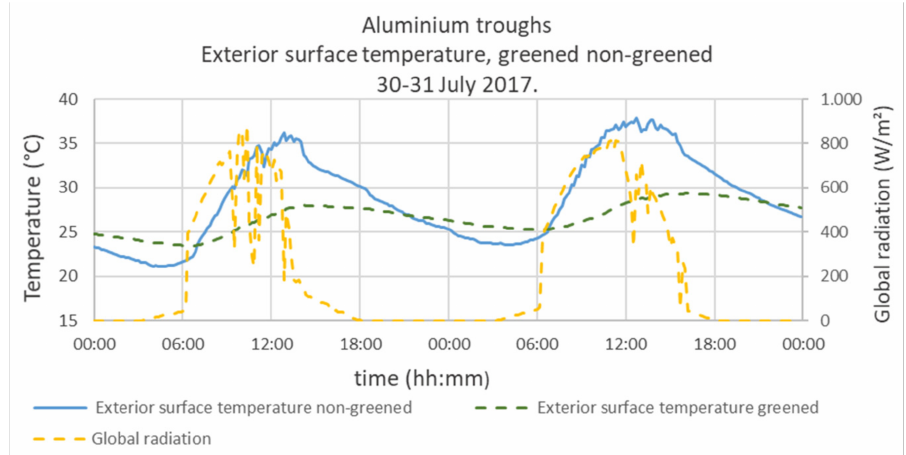
Figure 9. Aluminum troughs, exterior surface temperature, greened and non-greened, 30–31 July 2017.